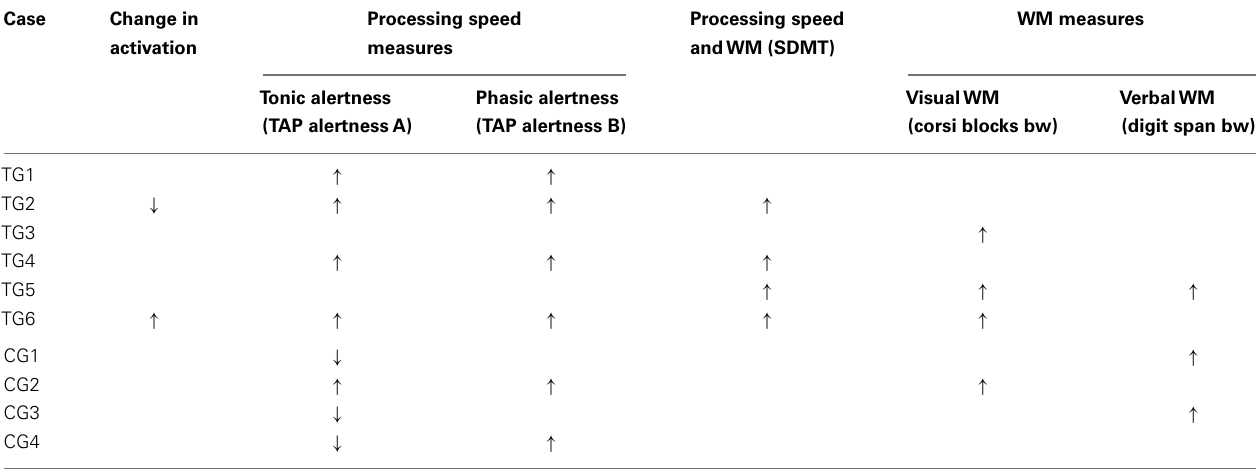
Table 3 | Summary table of changes from baseline to post-treatment for all participants .